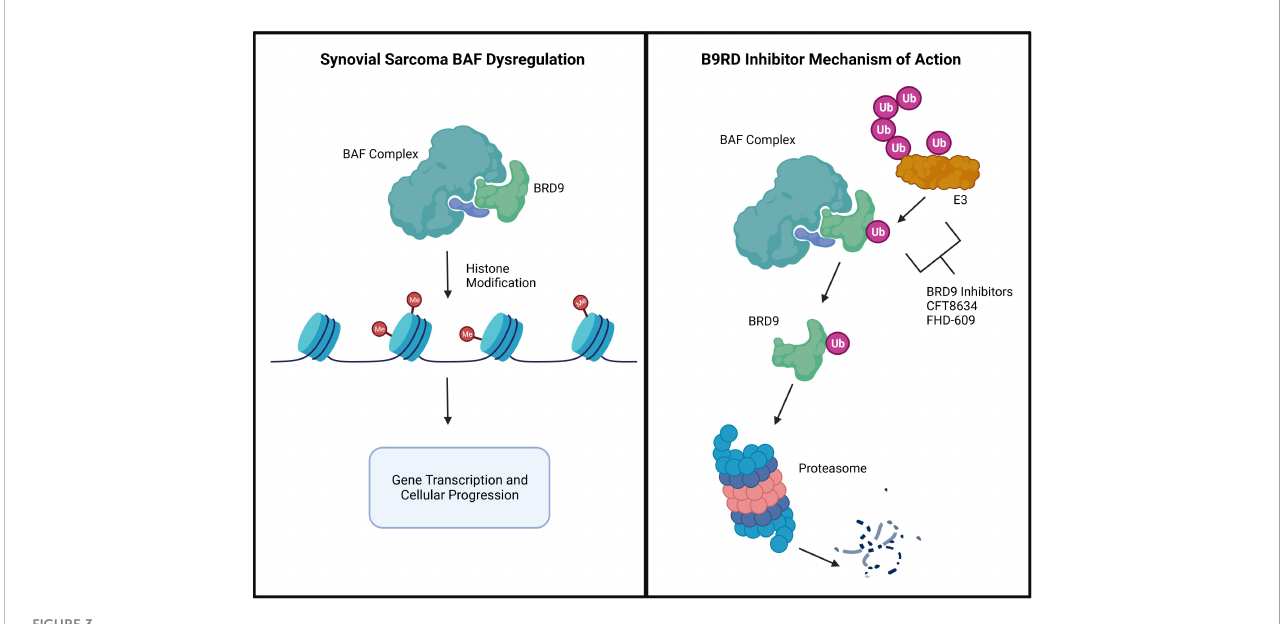
FIGURE 3 BRD9 inhibitor therapy for the treatment of